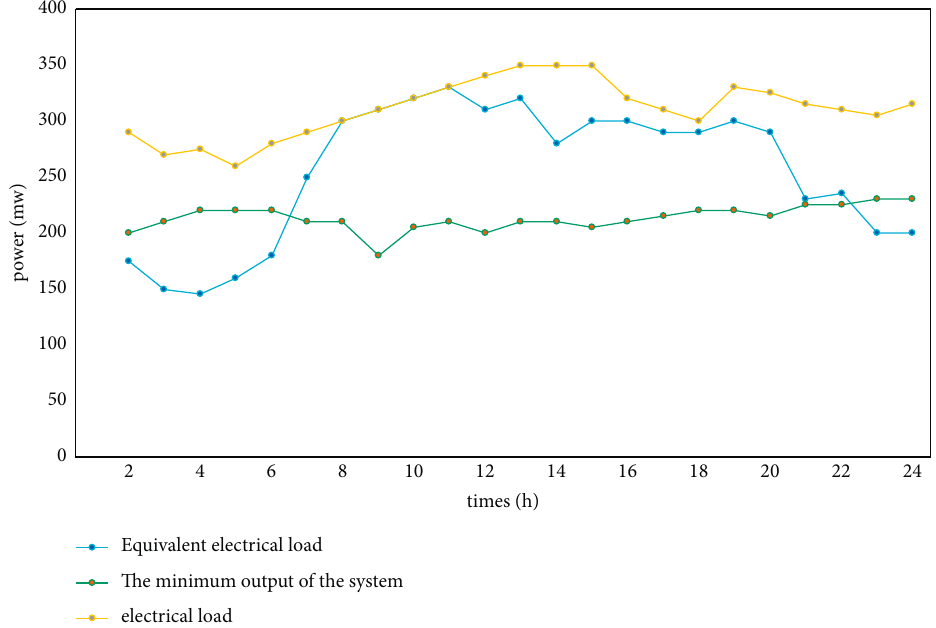
Figure 1: Principle of wind